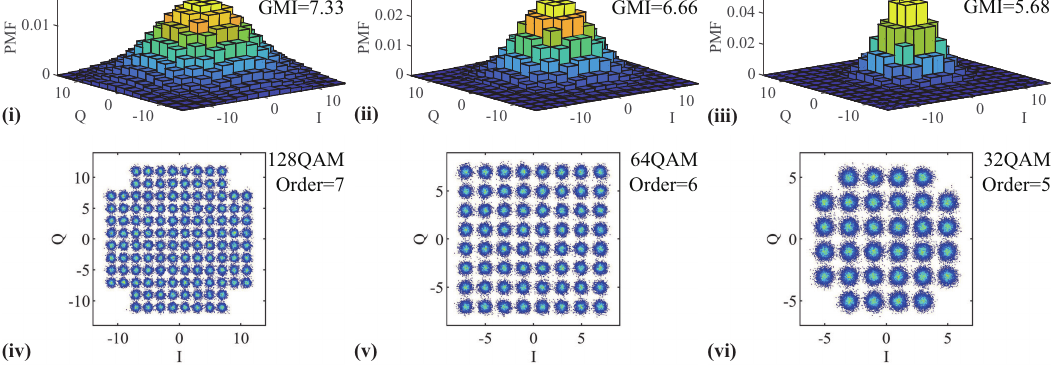
Figure 8. The distribution of PS constellations in the highlight subcarriers in Figure 7c with different GMI: ( i ) 7.13 bit/Hz, ( ii ) 6.66 bit/Hz, ( iii ) 5.68 bit/Hz, and the bitloading modulation in the same